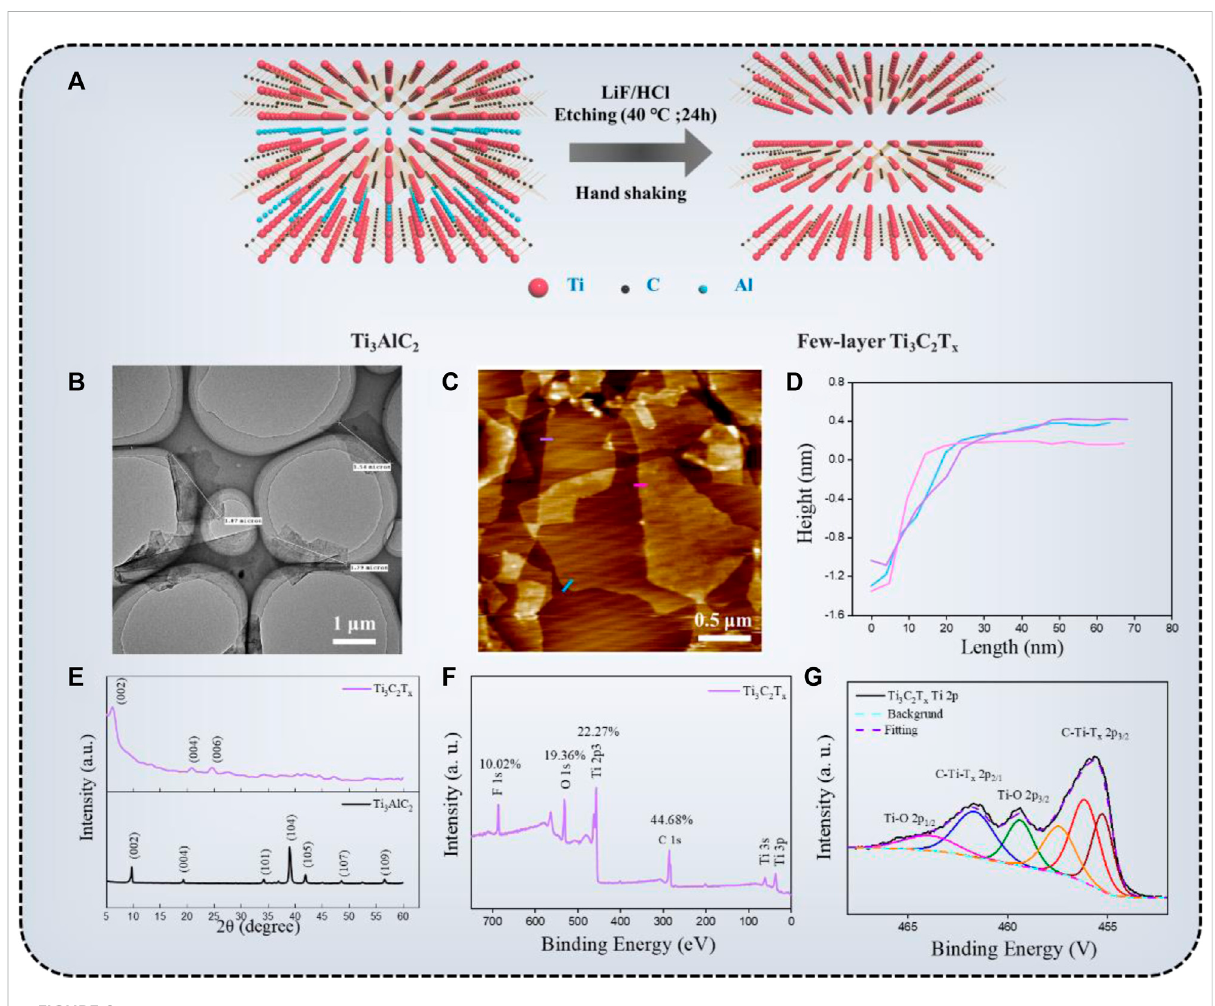
FIGURE 2 (A) The schematic illustration of the preparation of the Ti 3 C 2 T x via the MILD method; TEM micrograph (B) , AFM image (C) , thickness (D) , XRD spectra (E) , and XPS spectra (F,G) of the Ti 3 C 2 T x fl